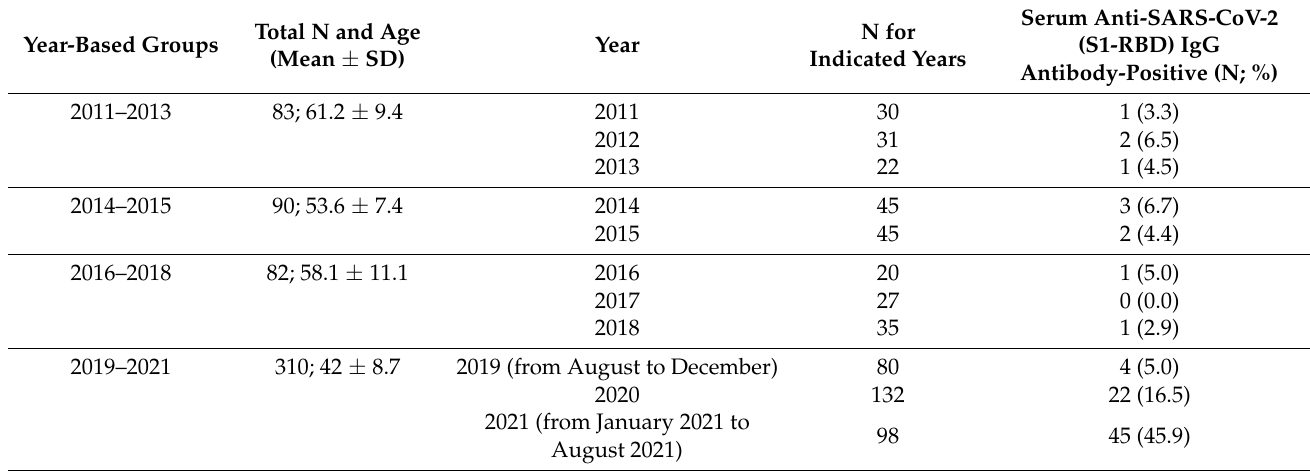
Table 1. Participants analyzed based on years from 2011 to 2021 and serum anti-SARS-CoV-2 IgG antibody